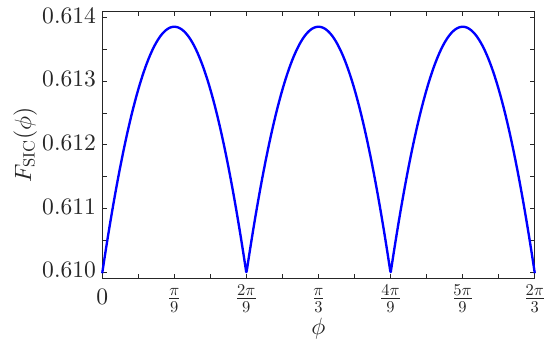
FIG. 8. Three-copy estimation fidelity F SIC (φ) achieved by the POVM A SIC (φ) ⊗ 3 , where A SIC (φ) is the SIC defined in Eq.